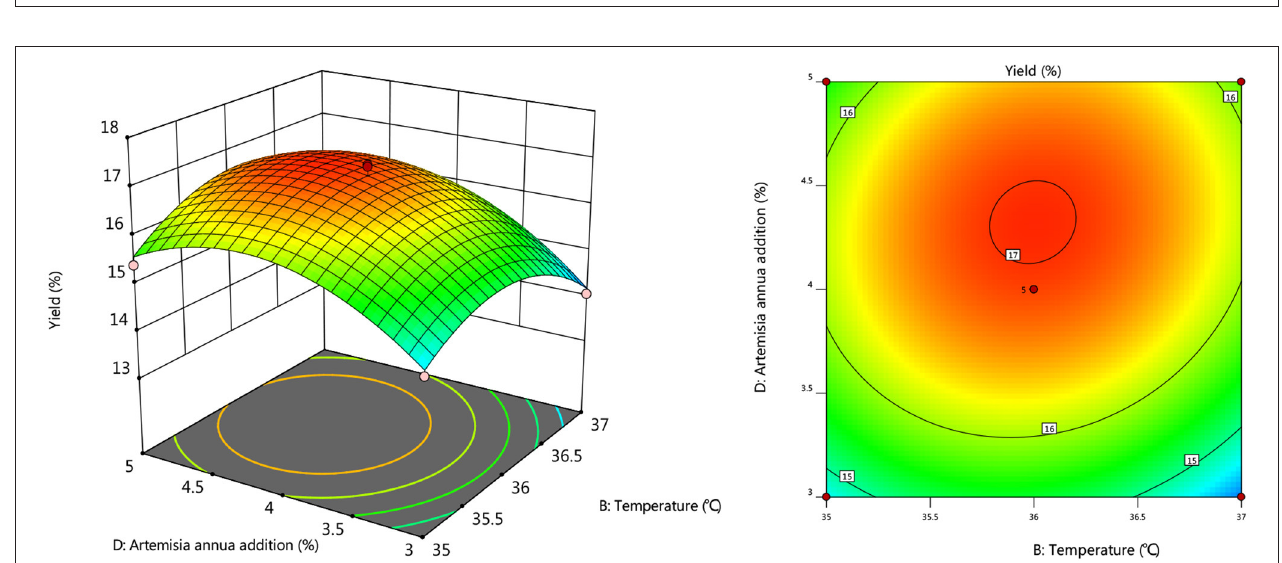
FIGURE 9 | Plot of the response of temperature and time on the interaction of yield.